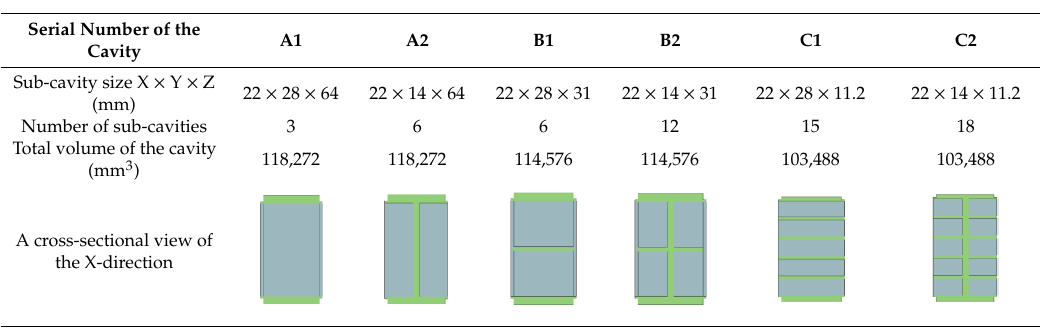
Table 1. Random excitation loading conditions.